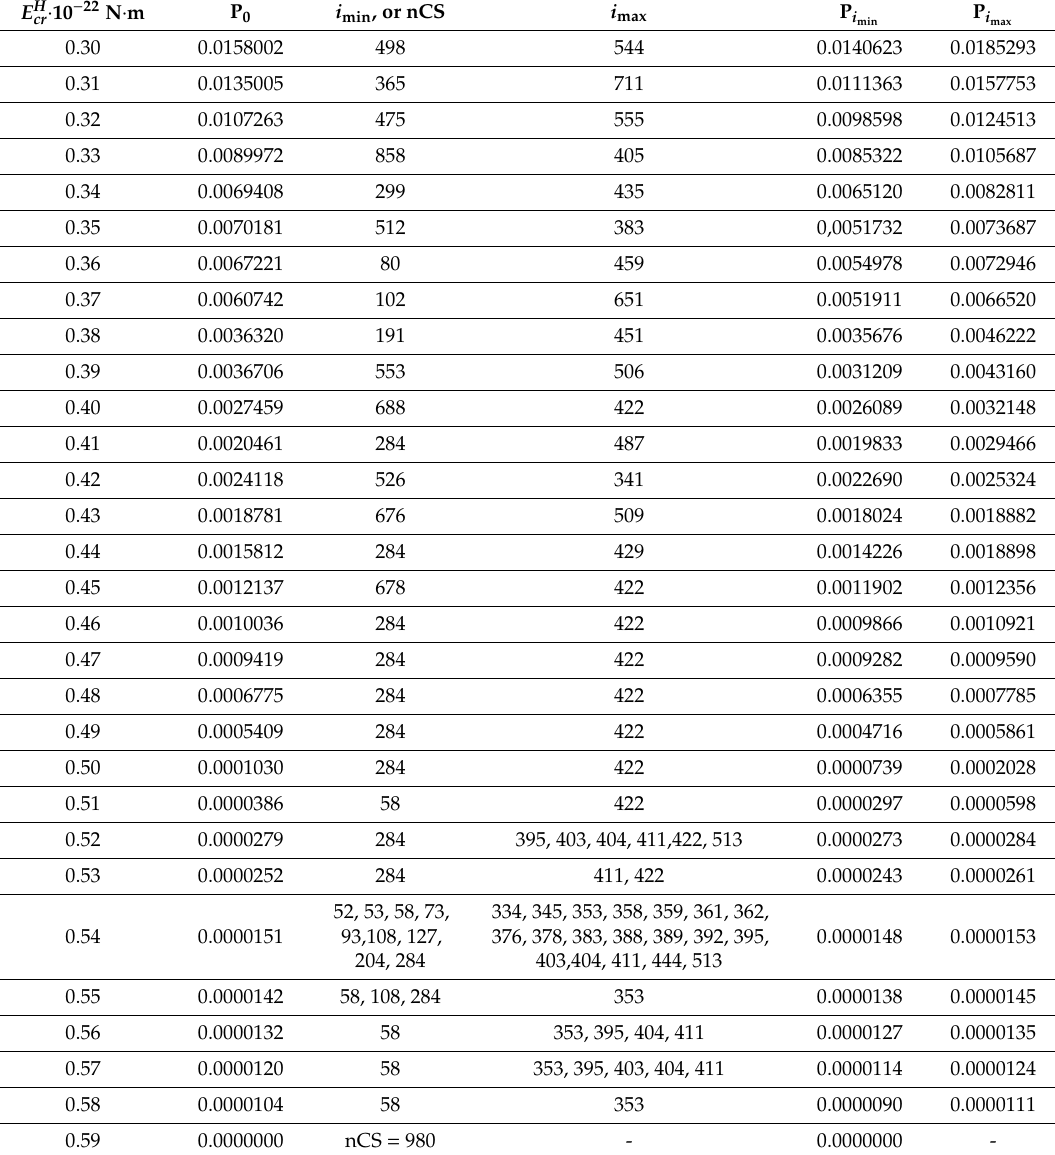
Table 2. Probabilities of occurrence of open states between di ff erent nitrogenous bases in double-stranded DNA dependent on single 2 H / 1 H